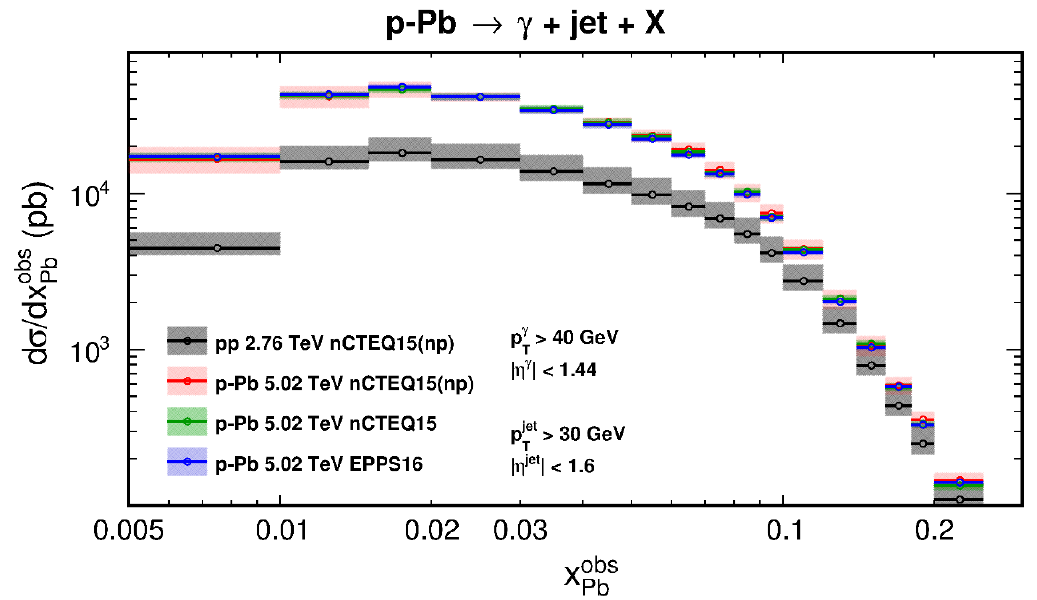
Figure 9 . Nuclear PDF sensitivity of central high- p (cid:13) or CMS in pPb collisions at the LHC with a nucleon-nucleon centre-of-mass energy of 5 : 02 TeV. Predictions with nCTEQ15(np) PDFs (red) are compared to those with nCTEQ15 in- cluding pion data from RHIC (green) and EPSS16 including weak boson and jet data from LHC (blue). The nCTEQ15 pp baseline is also shown